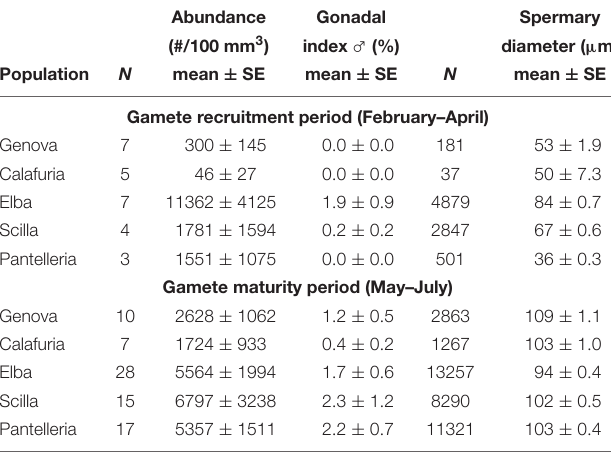
TABLE 4 | Mean abundance, gonadal index and diameter of spermaries in each population for gamete recruitment and gamete maturity periods. Abundance Gonadal Spermary